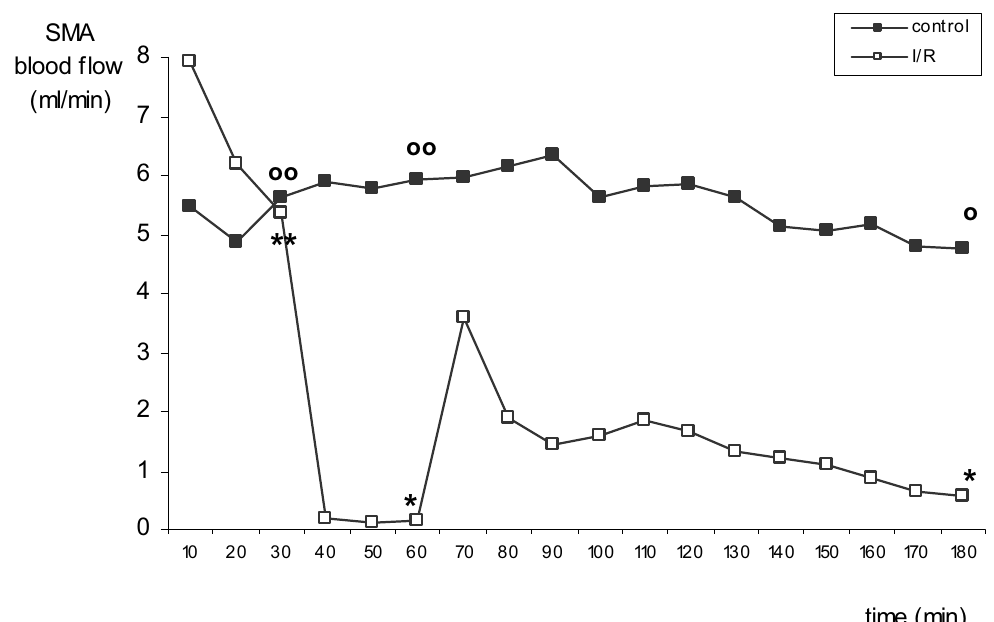
FIGURE 4 – Median superior mesenteric artery blood flow (ml/min) along time. Asterisk and circle indicate significant differences according experimental time in I/R and control groups, respectively (p <